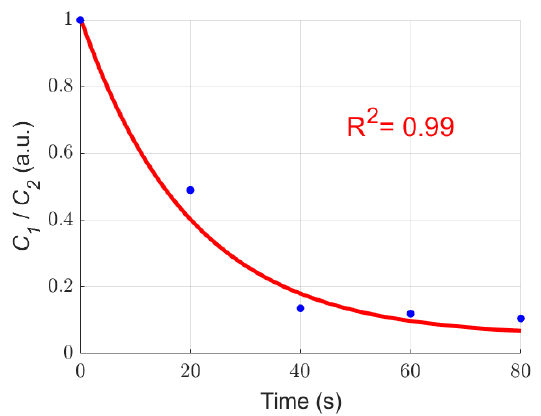
Figure 10. The exponential fitting curve of C 1 / C 2 with different ST times.